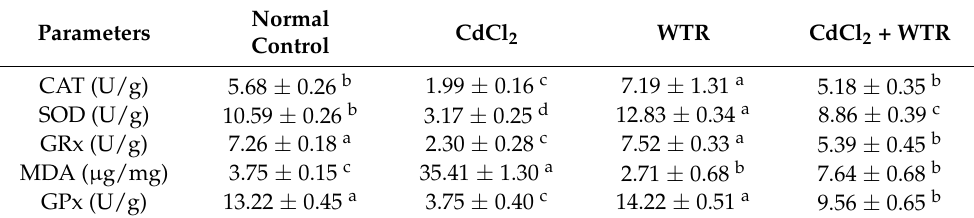
Table 3. Effects of the waste of Taif rose extract (WTR) on oxidative stress enzymes and oxida- tive damage markers in liver tissues of cadmium chloride (CdCl 2 )-intoxicated male rats versus normal